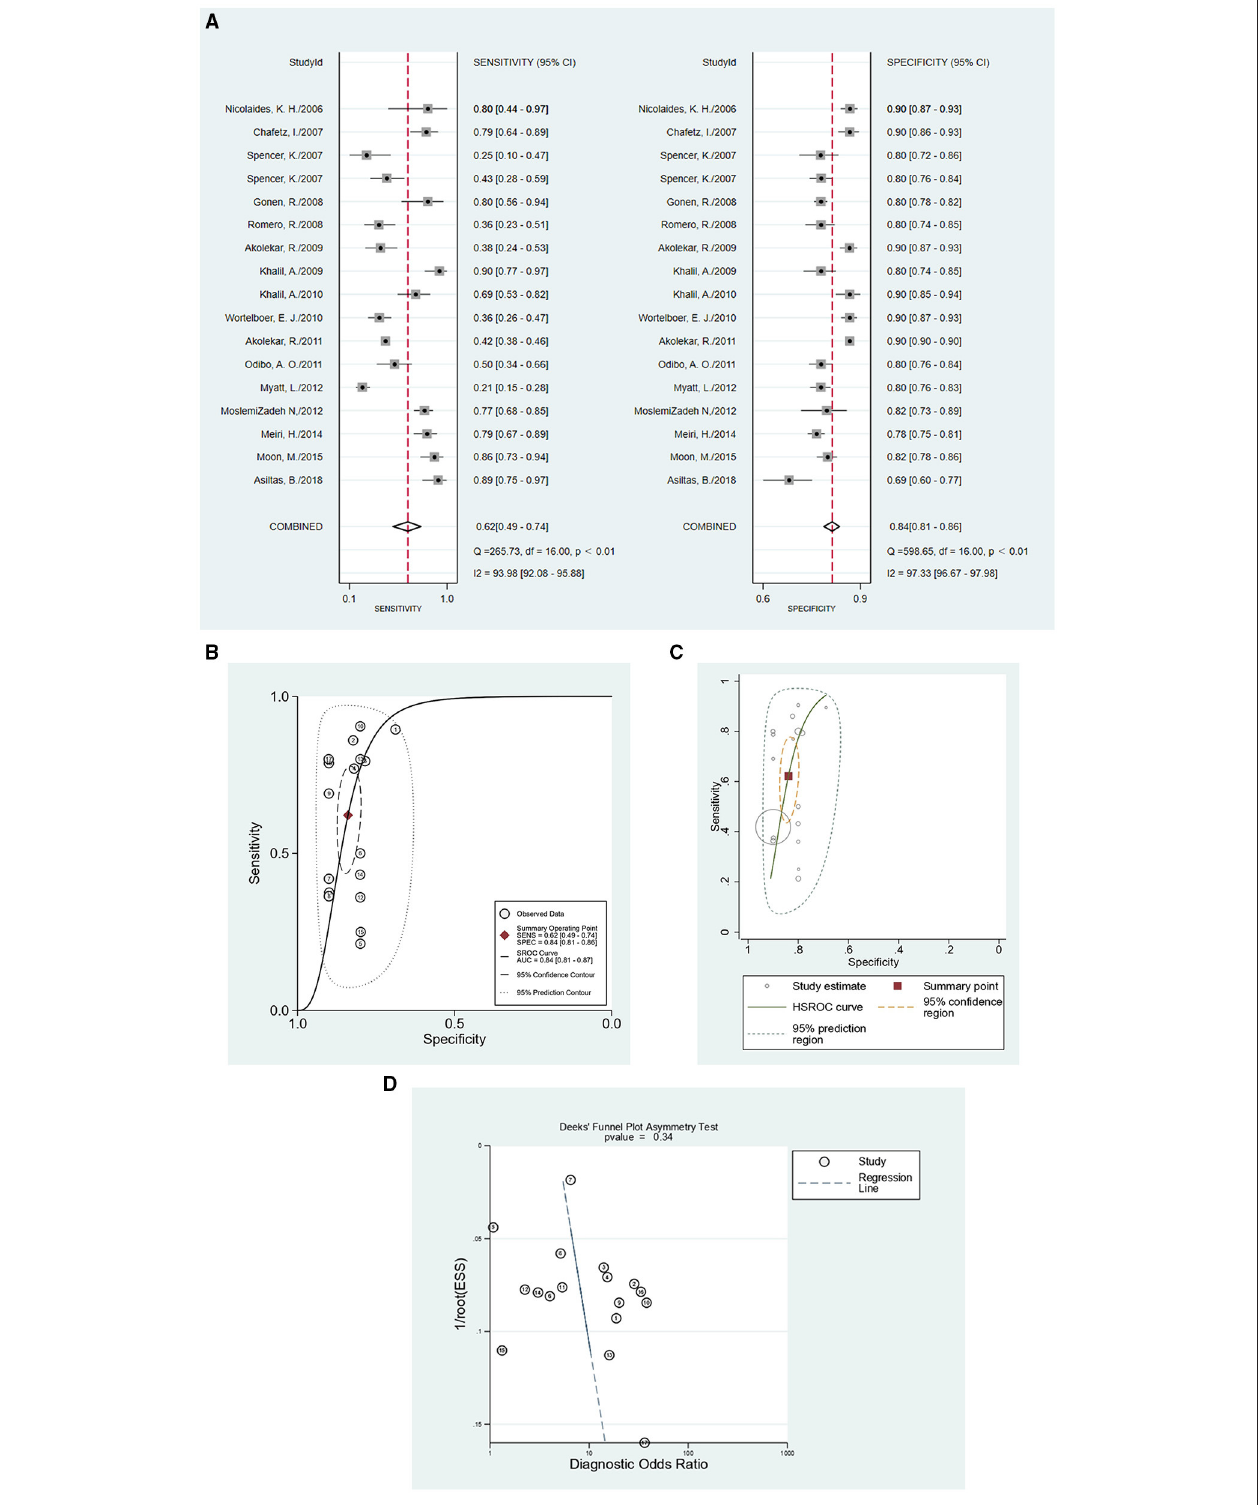
FIGURE 3 | The accuracy of PP13 as demonstrated by (A) forest plot, (B) SROC curve for all included studies, (C) HSROC curve for all included studies, and (D) publication bias test for all included studies.